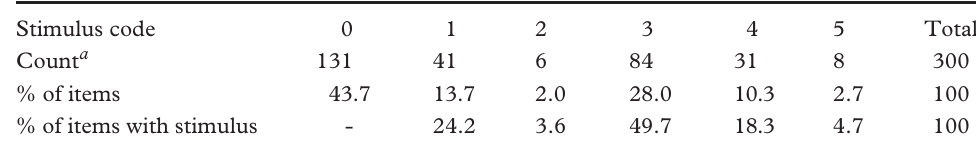
Table 2. Count of stimulus by